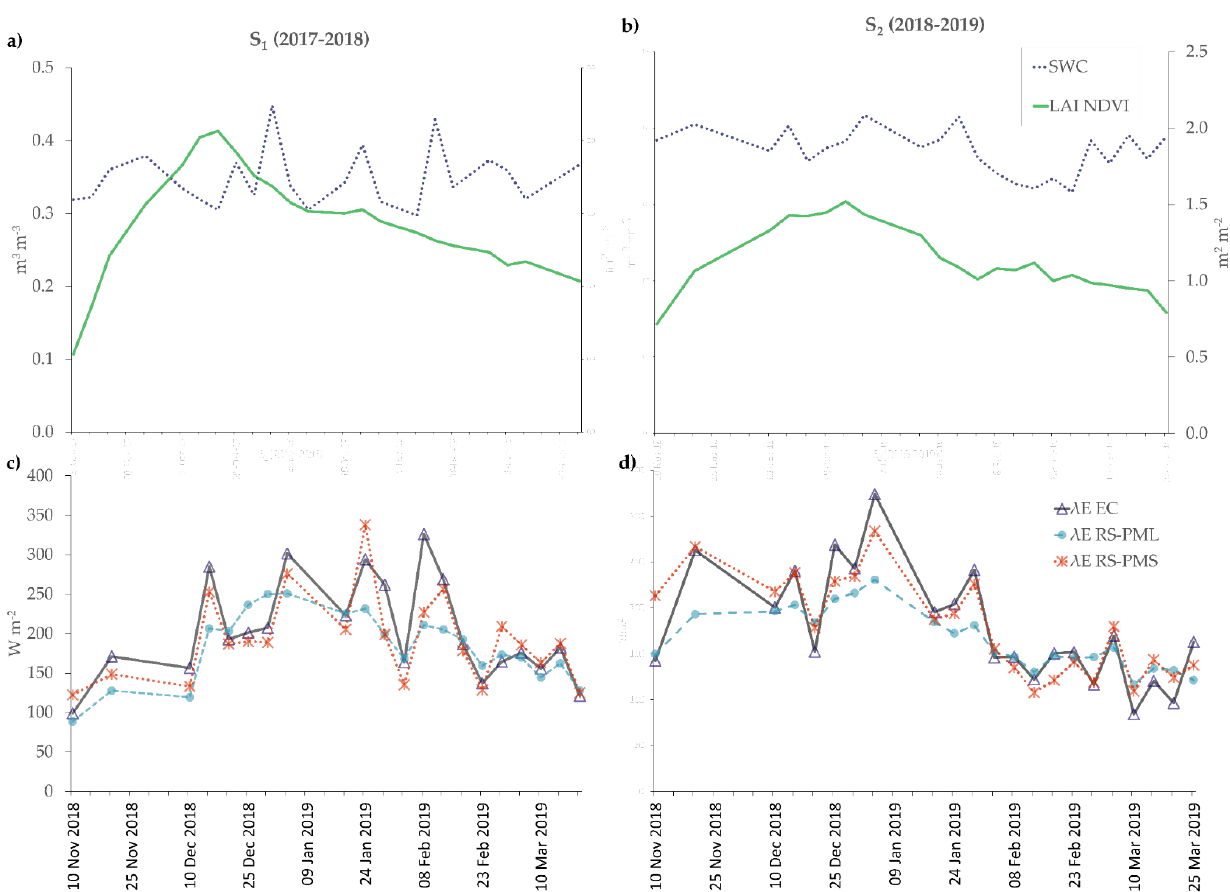
Figure 8. Biophysical variables involved in latent heat flux patterns (λE) during seasons S 1 (2017–2018) and S 2 (2018–2019) in Sentinel-2 satellite overpass time. ( a , b ) Soil water content (SWC) in m 3 m − 3 and leaf area index estimated from Sentinel-2 data (LAI NDVI) in m 2 m − 2 . ( c , d ) Instantaneous latent heat flux measured by eddy covariance (λE EC), modeled by Penman–Monteith–Leuning (λE RS-PML) and Penman–Monteith–Stewart (λE RS-PMS).